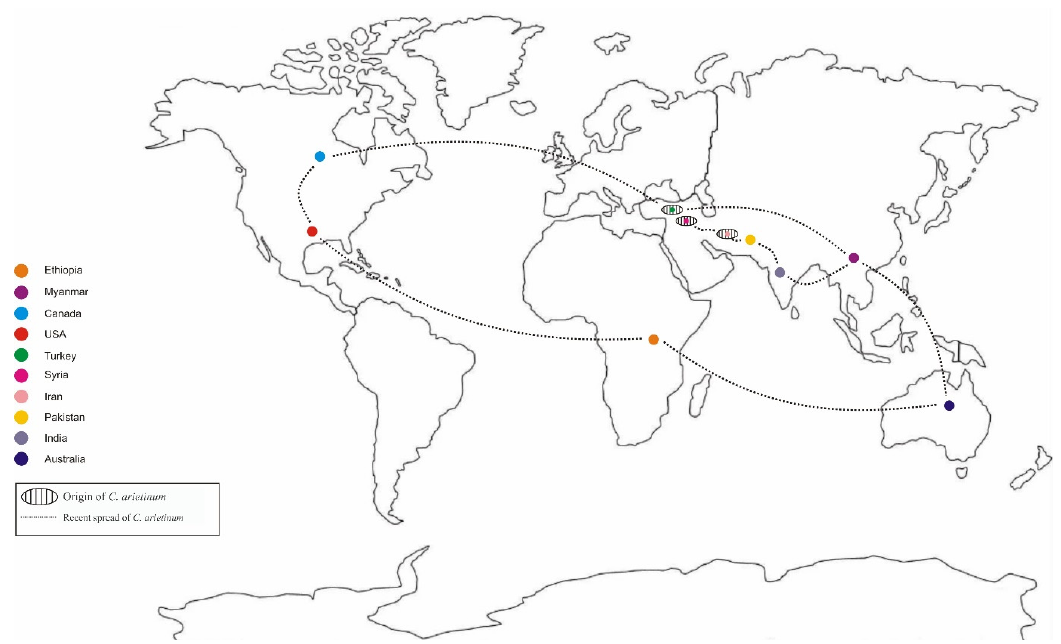
Figure 1. Origin of chickpea ( C . arietinum ) and its distribution around the world.